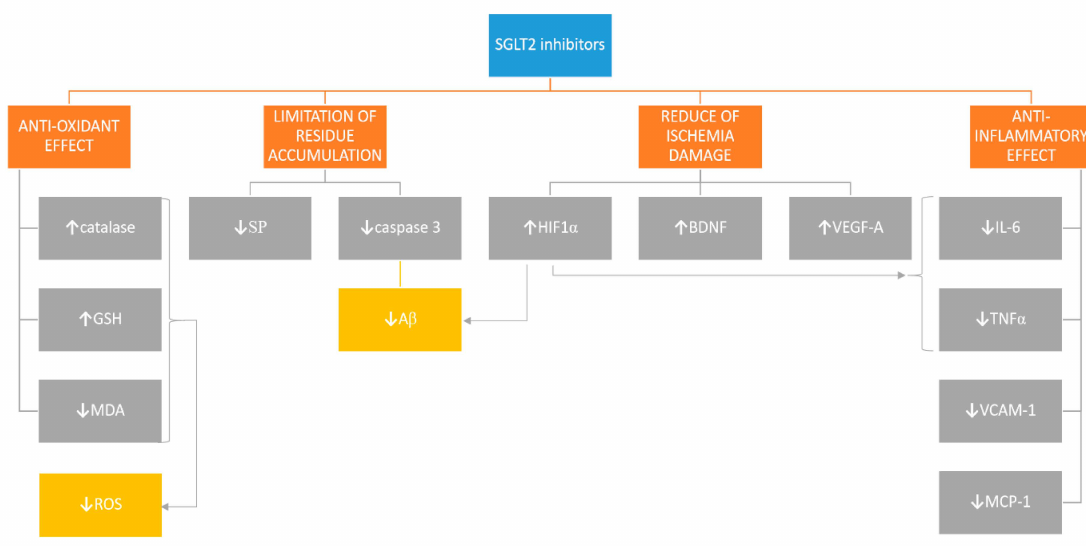
Figure 1. Proposed mechanisms of Sodium-glucose co-transporter 2 inhibitors (SGLT2i)